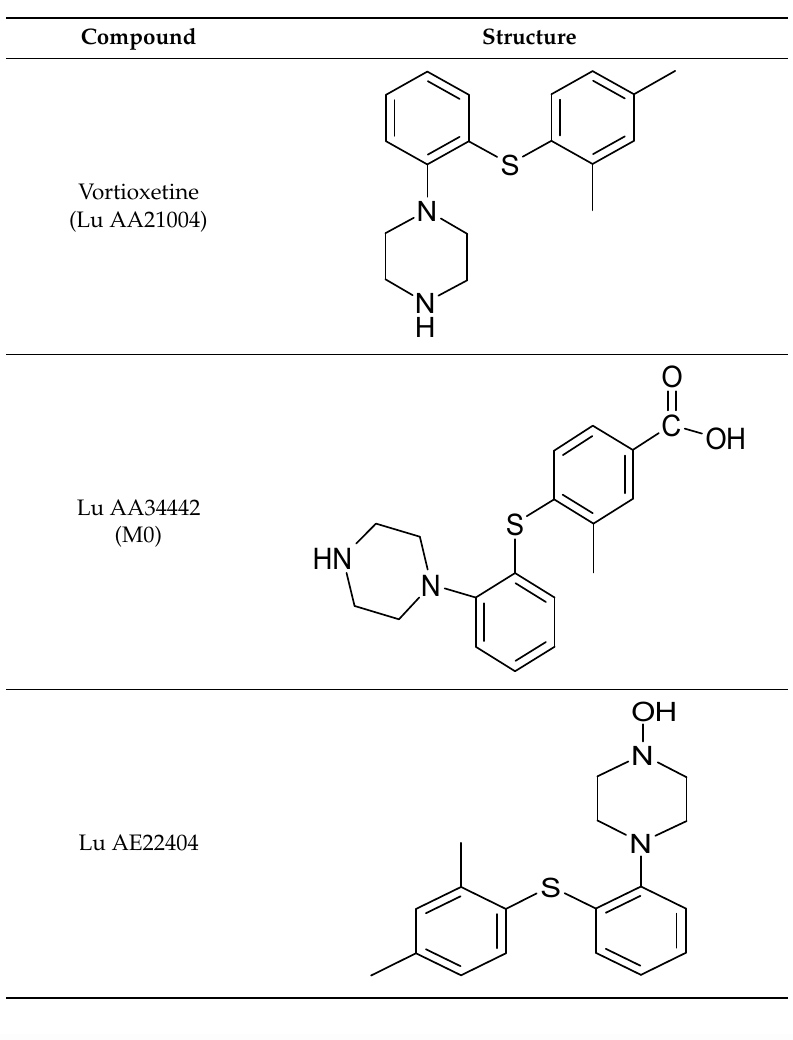
Table 4. Chemical structure of vortioxetine and its metabolites.